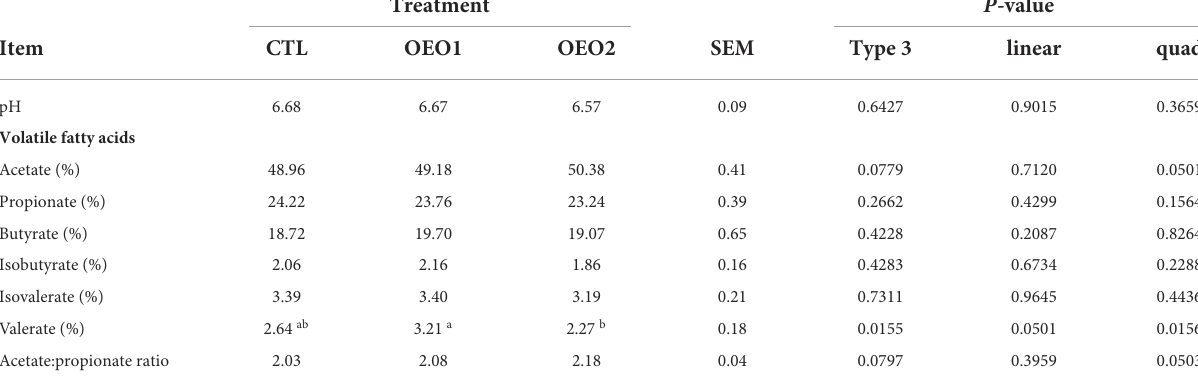
TABLE 8 Effect of orange essential oil (OEO) on rumen pH and volatile fatty acid (VFA) production in heifers ( n = 6).